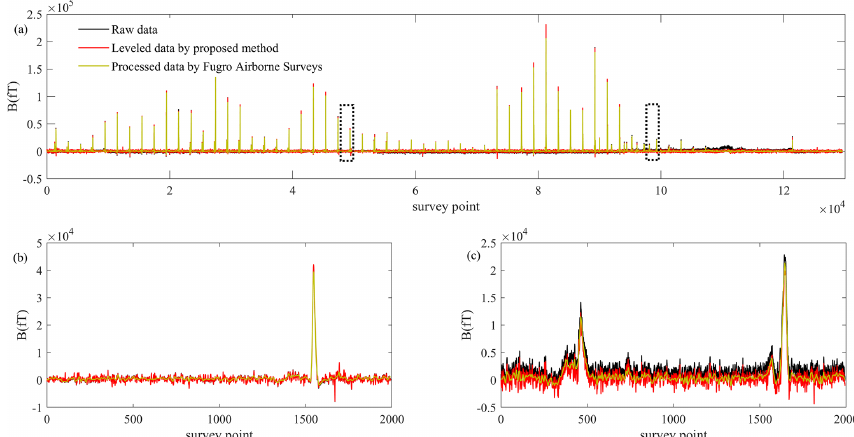
Figure 4. The result comparison analysis between the unidirectional variational model algorithm and Fugro Airborne Surveys. (a) All flight line data. (b) The 25th flight line data, corresponding to the first black dotted rectangle in (a) . (c) The 50th flight line data, corresponding to the second black dotted rectangle in (a)